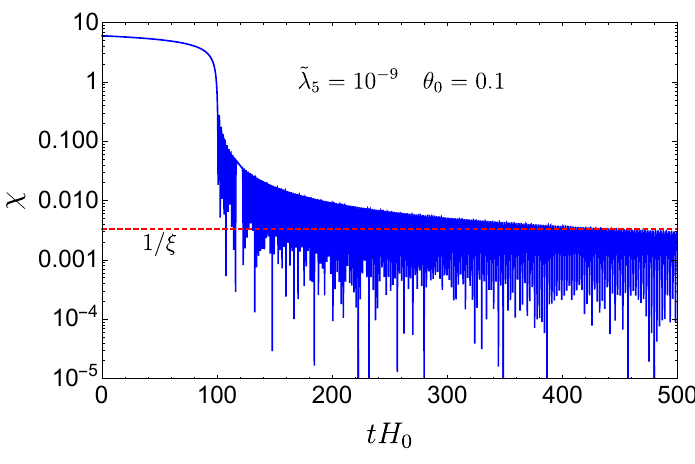
Figure 1 . The evolution of χ during and after inflation is depicted, in Planck units. The following input parameters are chosen to be ξ = 300 and λ = 4 . 5 · 10 − 5 , with the initial conditions χ ˙ χ = 0 , and ˙ θ = 0 used. We require that ˜ µ is sufficiently small to not affect the inflationary 0 0 dynamics, and we define H 2 0 ≡ m S /